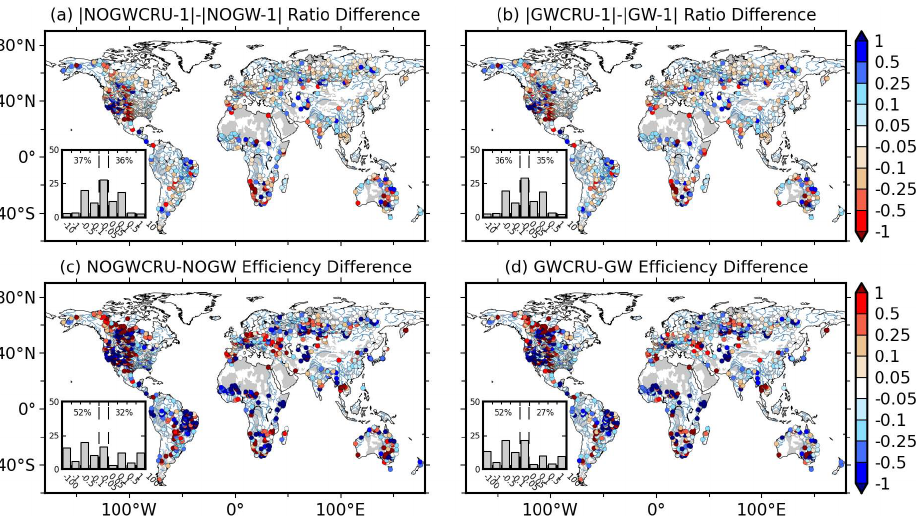
Fig. 9. Statistical comparison of the simulated discharges inferred from the CRU and GPCC precipitation datasets. The annual ratio differ- ences (a) without and (b) with groundwater are given, together with the efficiency differences (c) without and (d) with groundwater.